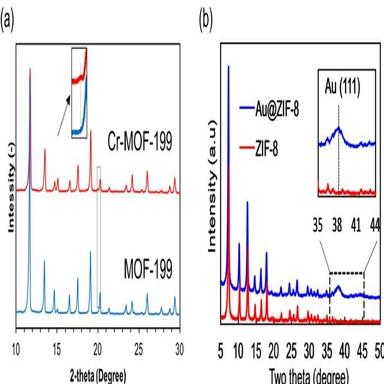
XRD images of (a) Cr-MOF-199 compared to MOF-199, and (b) Au@ZIF-8 compared to ZIF-8. (a) Reprinted with permission from Ref.. (b) Reprinted with permission from Ref. .